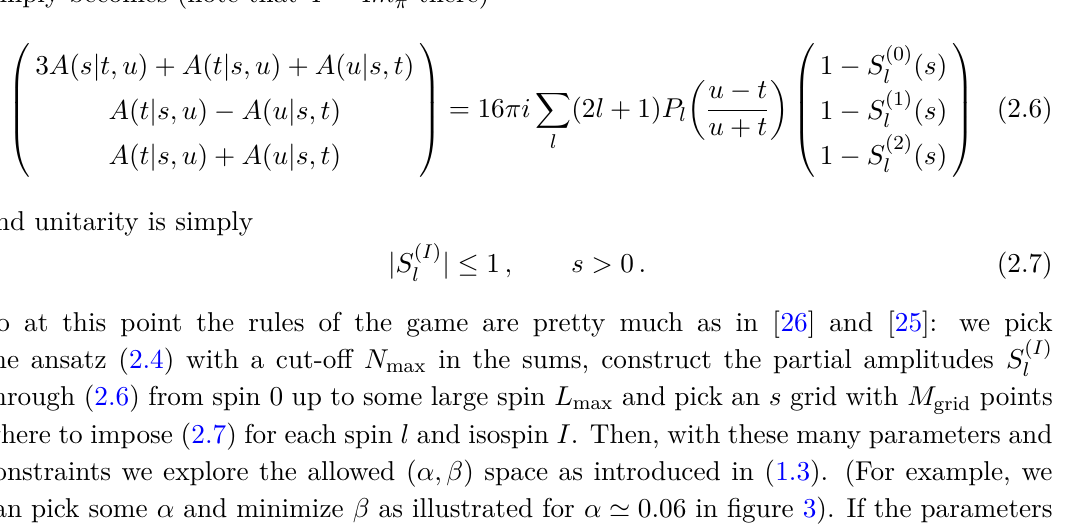
Figure 3 . (a) Example of a phase shift δ 0 (corresponding to α = 0 . 062 , spin ‘ = 0 and isospin I = 0 ) as a function of ˆ s = s/f 2 N max . The phase shift seems to have converged to a nice resonance like shape. (b) The